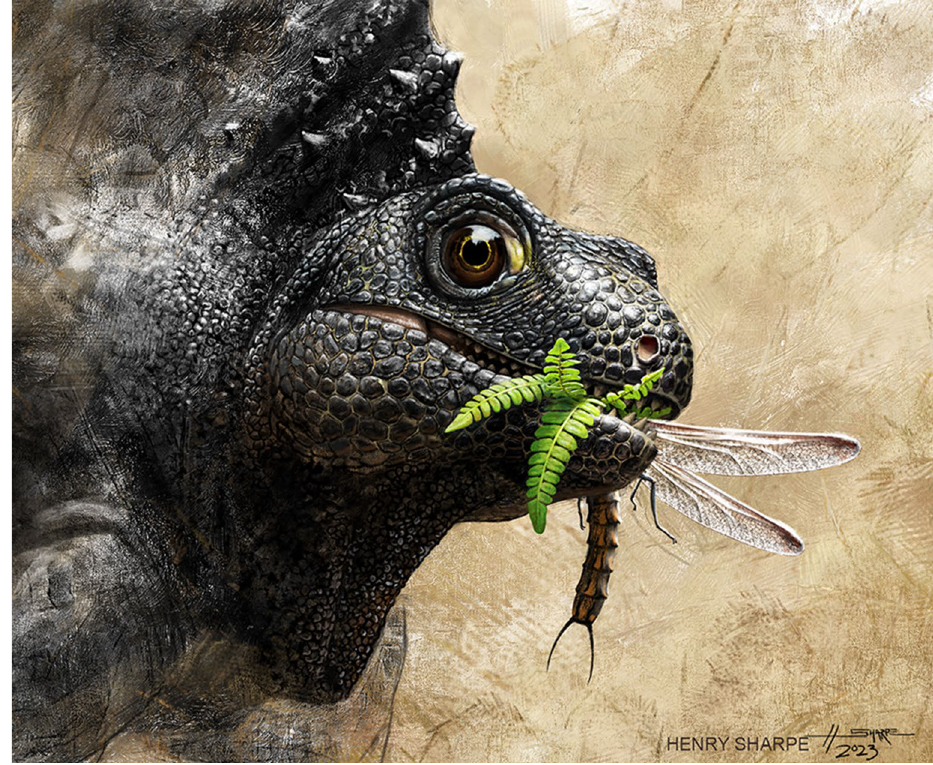
Figure 7. Life reconstruction of Melanedaphedon hovaneci gen. et sp. nov. (created by Henry Sutherland